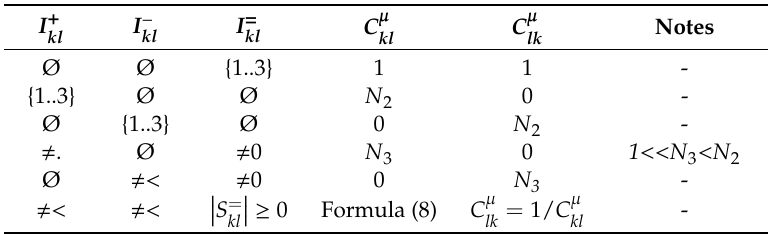
Table 4. Evaluation